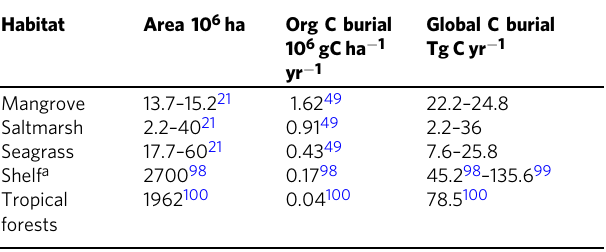
Table 1 Global estimates of carbon burial in individual ecosystems de fi ned by their vegetation, and/or geomorphological characteristics in coastal wetlands, shelf sediments and tropical forests; illustrating that on a global scale, the carbon sink in shelf systems is comparable to that in tropical